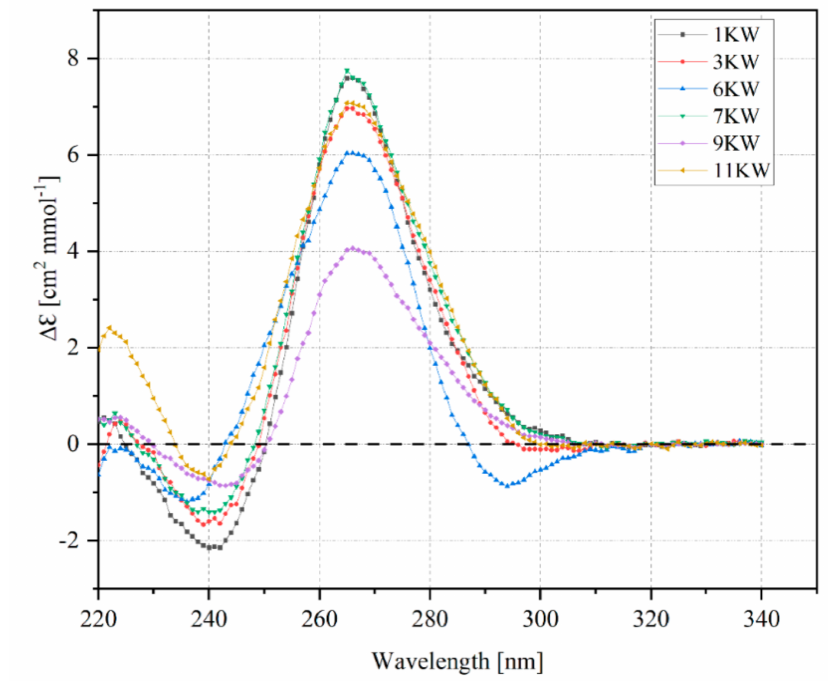
Figure 3. Circular dichroism (CD) spectra of model PQS oligomers recorded at 10 ◦